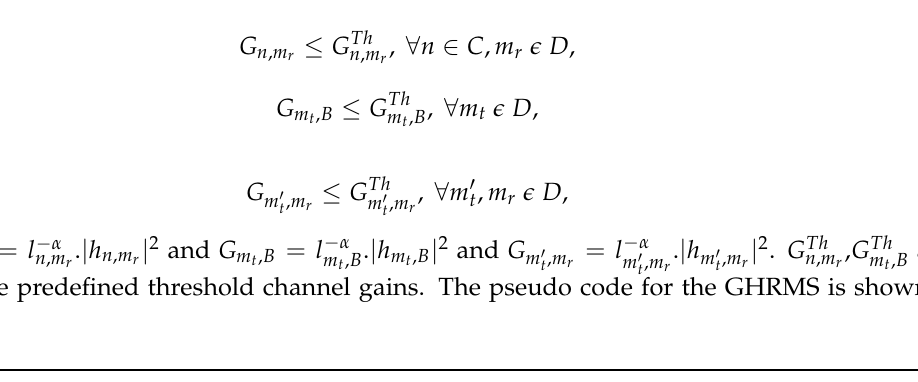
Algorithm 1: Greedy Heuristic Resource Management